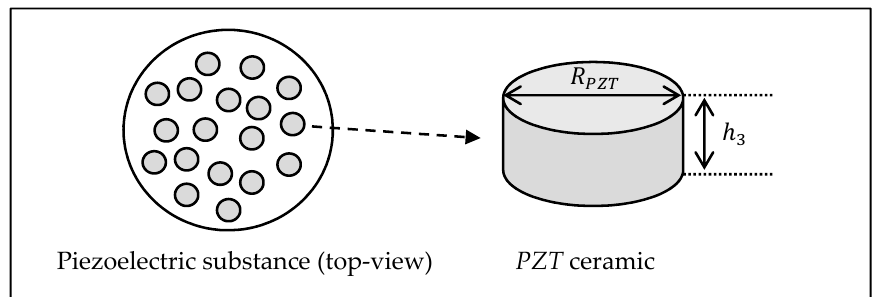
Figure 4. The diameter and thickness of the lead–zirconate–titanate ( PZT) ceramic. Table 2. Piezoelectric Energy Harvester Parameters.